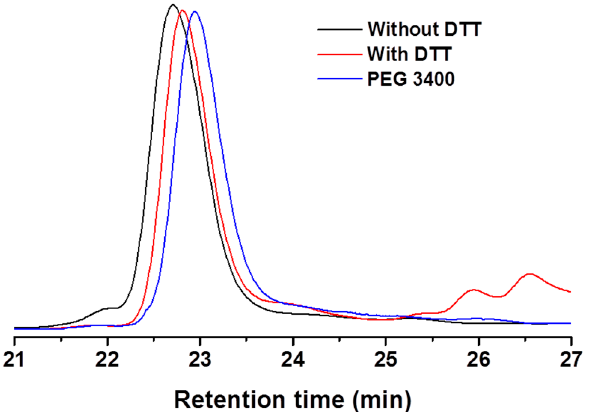
Figure 5. Gel permeation chromatography (GPC) traces of PEG and Chol-ss-PEG-ss-Chol before and 6 h after treatment with 10 mM DL -dithiothreitol (DTT).